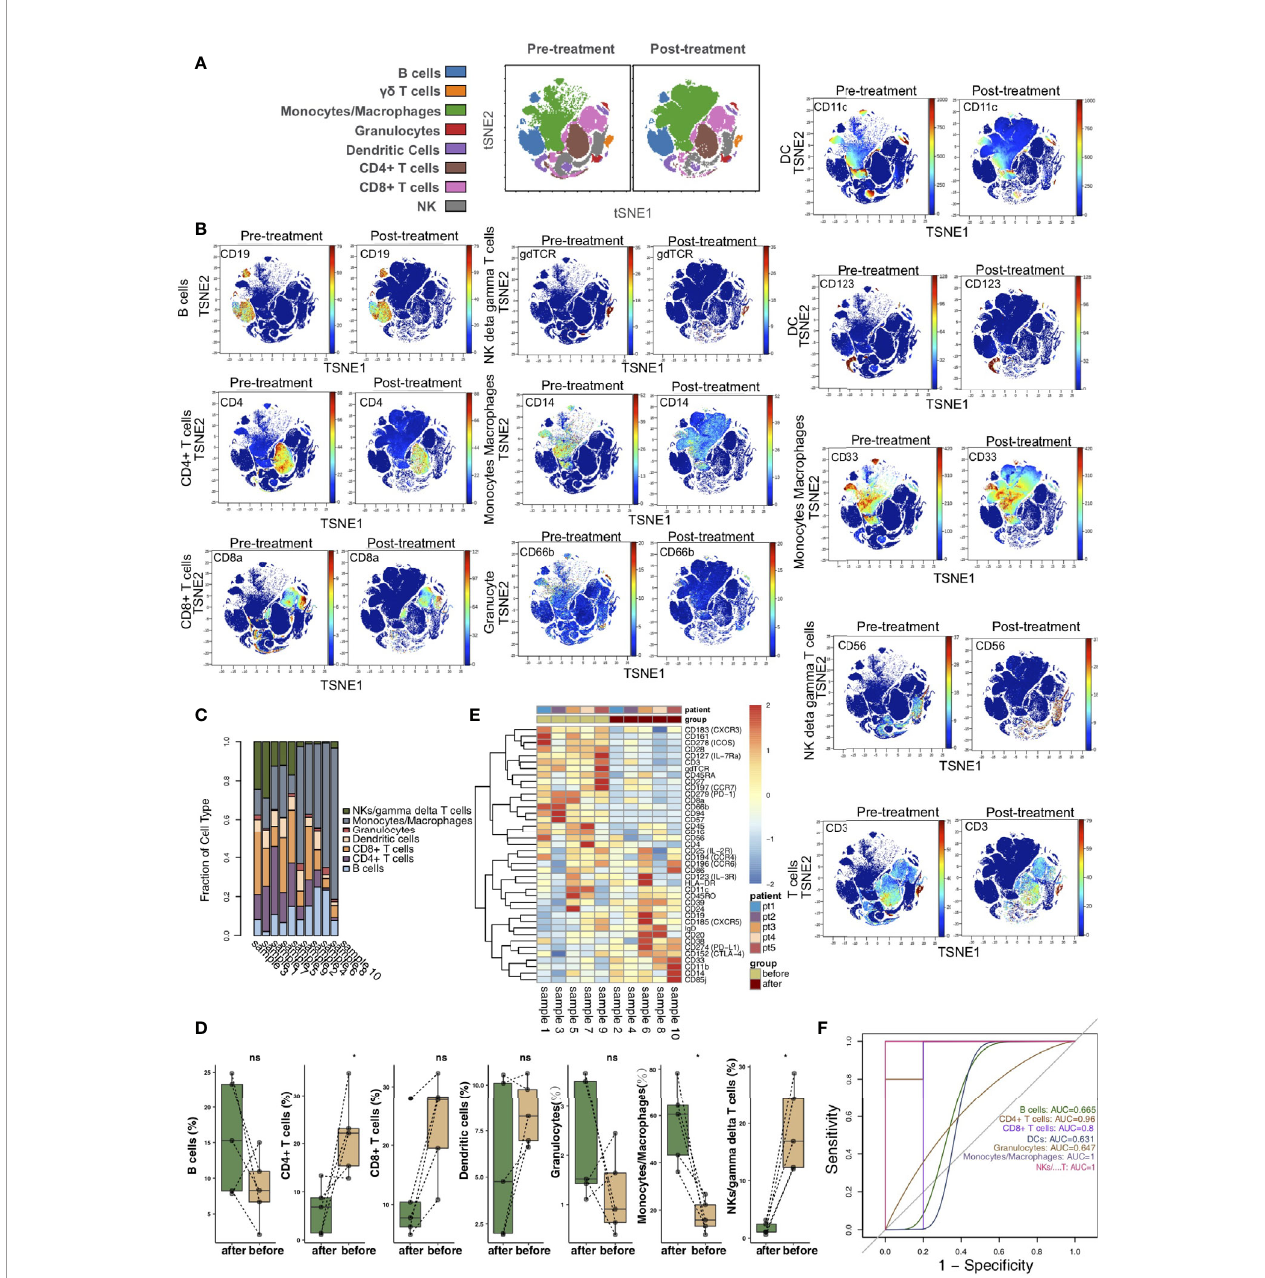
FIGURE 1 | The immune landscape of the kidney. (A) t-SNE plots of CD4+ T cells, CD8+ T cells, B cells, NK cells/ gd T cells, monocytes/macrophages, granulocytes, and dendritic cells. (B) t-SNE plots of CD19, CD3, CD4, CD8a, CD56, gdTCR, CD33, CD14, CD66b, CD11c, and CD123 expression in the pre- and posttreatment groups. (C) The proportions of main cell types in all samples. (D) Comparison of the proportions of main cell types between the pre- and posttreatment groups. (E) Heatmap of the marker expression for all samples. (F) ROC curve of the main cell types predicting the pre- and posttreatment groups. *P<0.05; ns, not signi fi